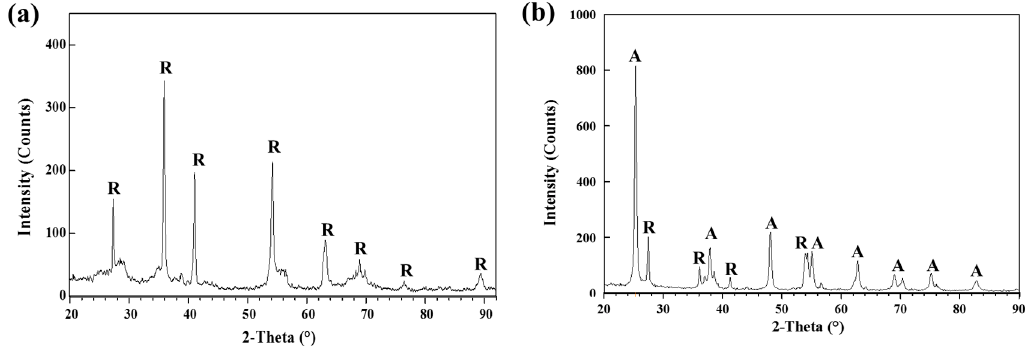
Figure 3. X-ray diffraction patterns of the films fabricated by ( a ) thermal spray coating and ( b ) screen printing. The marked letters of A and R indicate respectively the TiO 2 phases of anatase and rutile.